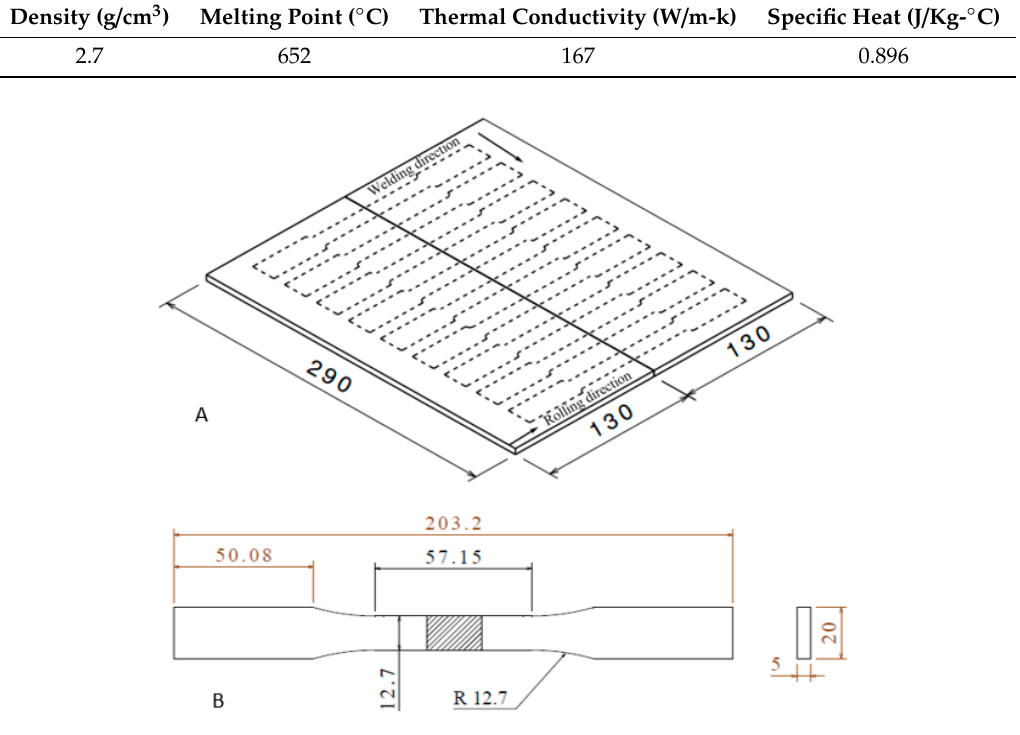
Table 3. Thermo-physical properties of 6061 aluminum alloy material [26,27].